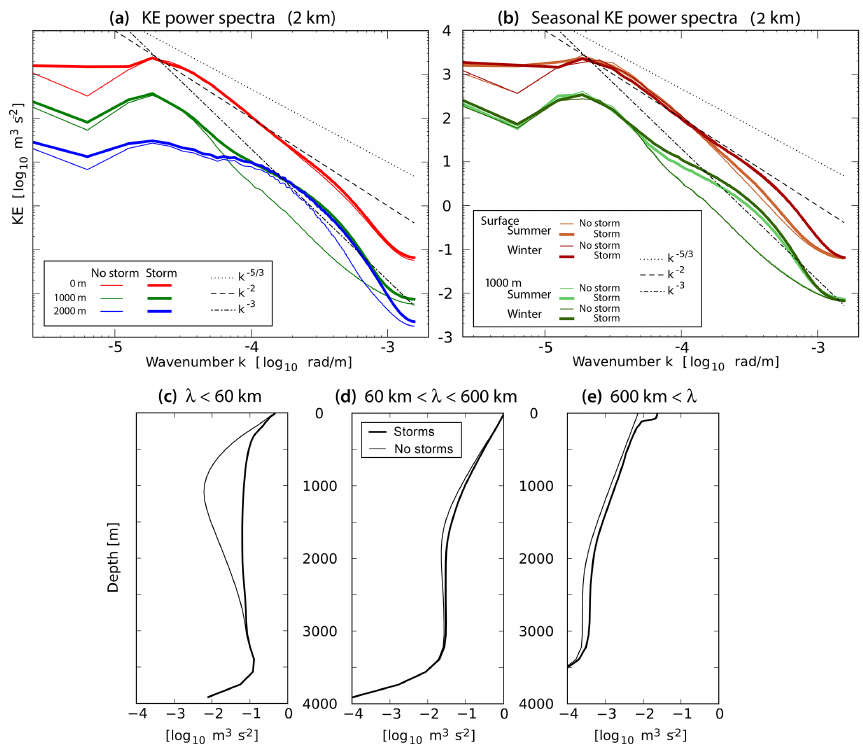
Figure 4. Horizontal velocity variance in the 2km reference experiments with and without storms. (a) Kinetic energy power spectra as a function of wavenumber (radm − 1 ) at 0, 1000 and 2500m depth. (b) Seasonal (summer is defined as December–January–February and winter as June–July–August) kinetic energy power spectra at 0 and 1000m depth. Spectra are built using instantaneous velocity taken each 5 days of the last 2 years of the 2km simulations. Kinetic energy contained in the wavelength ranges λ < 60km (c) , 60km < λ < 600km (d) and λ > 600km (e) as a function of depth. In (b) and for wavenumber above 5 × 10 − 5 radm − 1 , the winter surface spectra with and without storms (dark red thin and thick lines) are superimposed, as well as the summer and winter 1000m spectra without storms (light and dark green thin